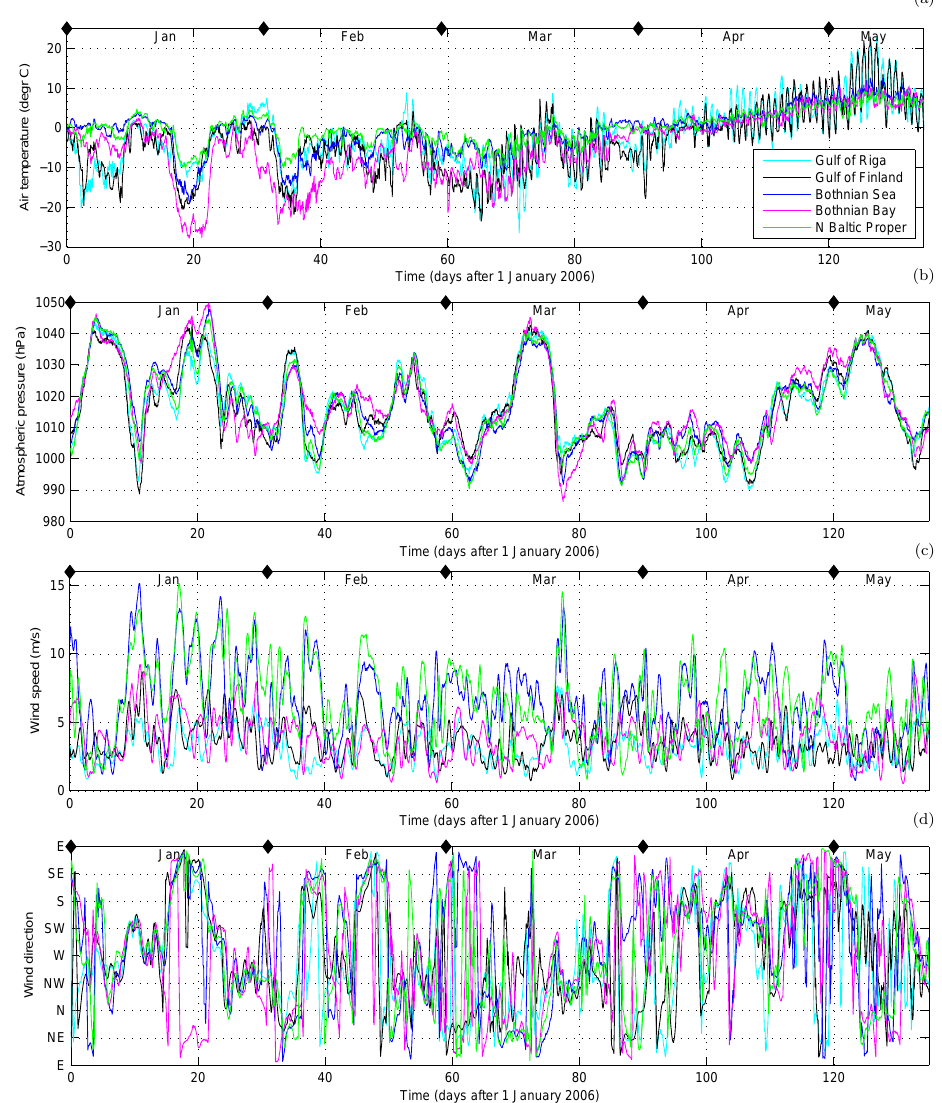
Fig. 6. Time series of the air temperature (a) , atmospheric pressure (b) , wind speed (c) and direction (d) in winter 2005/2006 at five sites marked with asterisks in Fig. 1. The temporal resolution is 1h in (a, b) and 12h in (c, d)